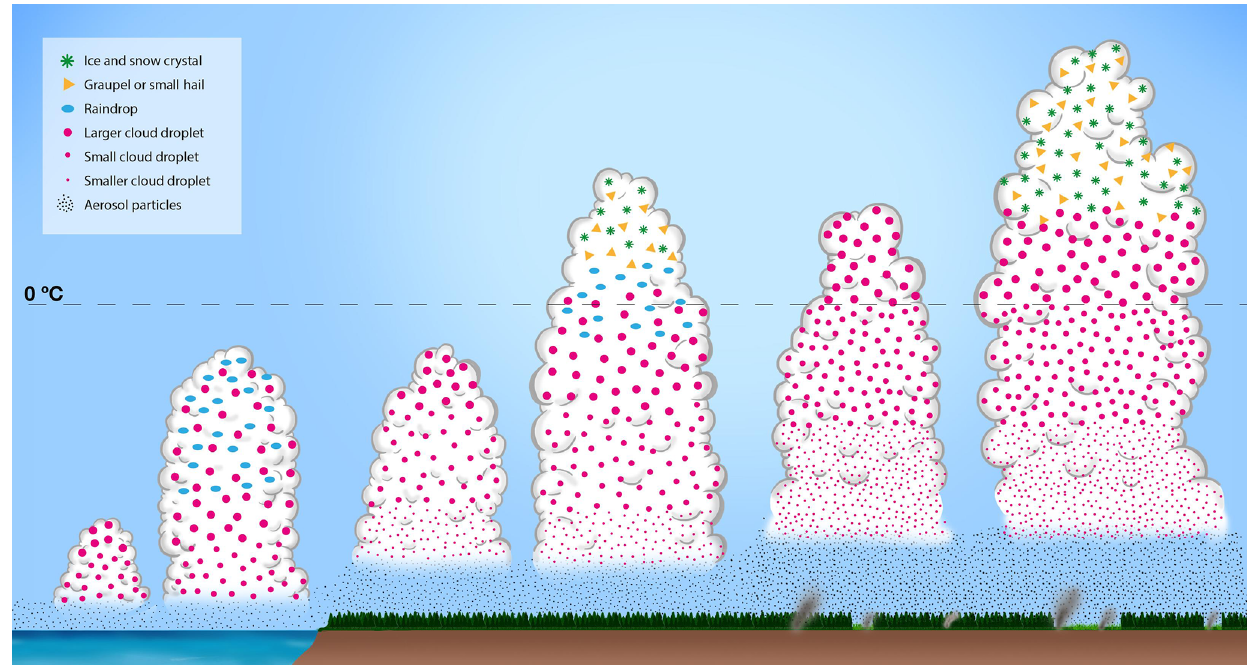
Figure 17. General characteristics of growing convective cumulus formed over the Amazon basin during the dry season. The heights of cloud base are higher over the continental Amazon due to the smaller relative humidity in comparison with the maritime region. Convective clouds formed over the Atlantic Ocean near the Brazilian coast have smaller cloud droplet concentrations ( N d ) at cloud base due to the smaller concentration of aerosol and updraft speeds below cloud base. The initiation of warm rain ( D r ) is observed at lower cloud depths ( ∼ 2km or ∼ 10 ◦ C) from collision and coalescence processes. When convective clouds are more continental, larger aerosol concentration and updrafts are observed below cloud base, leading to larger N d nucleated at cloud base (as observed above forested and deforested regions). Over the forest D r is observed near 0 ◦ C, whilst for the deforestation arc region the collision and coalescence processes are totally suppressed and the formation of ice particles took place at higher altitudes in the clouds in very polluted conditions because the resulting smaller cloud droplets froze at colder temperatures compared to the larger drops in the less polluted